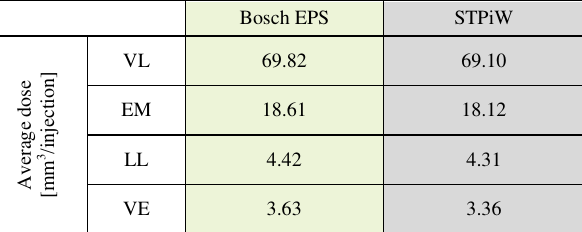
Table 4. Average results of measurements